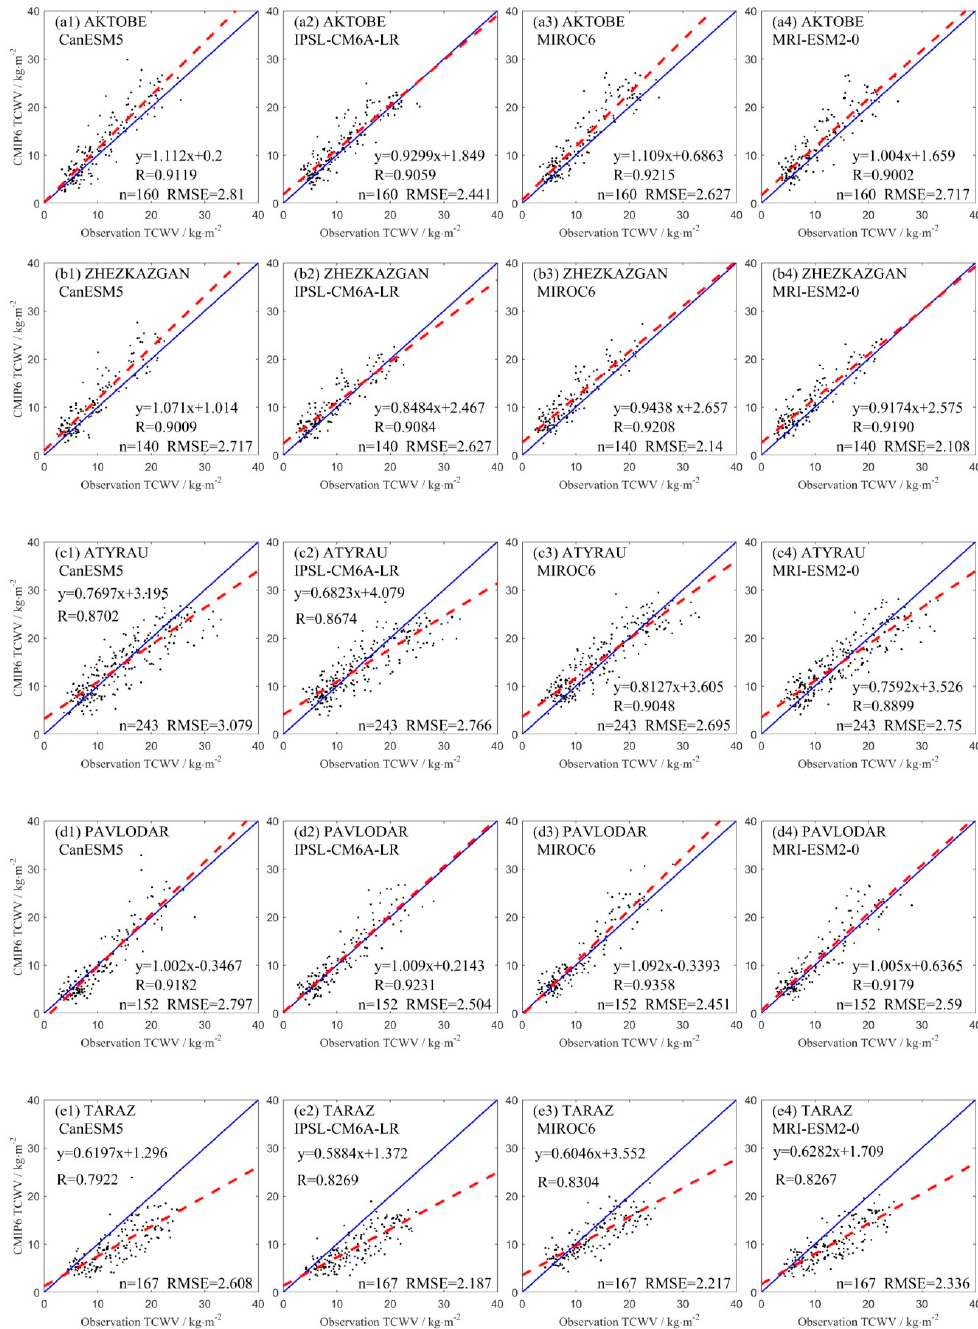
Figure 3. Scatter plot of monthly total column water vapor (TCWV) in historical CMIP6 four model’s simulation against sounding stations measured TCWV at five stations: ( a 1– a 4) AKTOBE, ( b 1– b 4) ZHEZKAZGAN, ( c 1– c 4) ATYRAU, ( d 1– d 4) PAVLODAR, ( e 1– e 4) TARAZ from 1979–2014 in Central Asia. Each column represents data from different stations compared within the same CMIP6 model. The solid line is the 1:1 line, and the dash one represents the ‘regression line’. n represents the number of months actually used for comparison; RMSE is the root mean square error between the observed data and CMIP6 data.